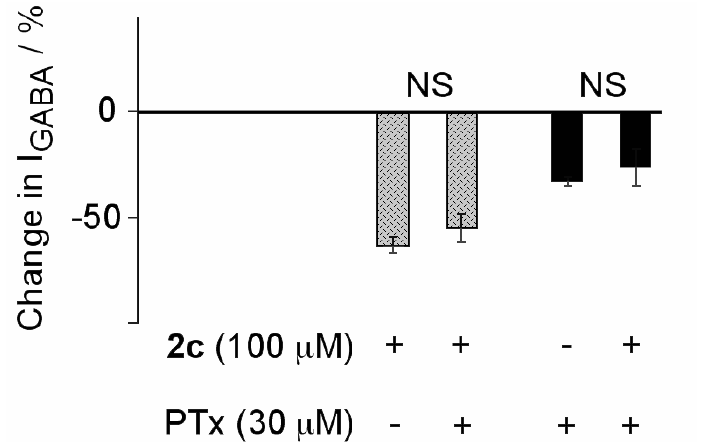
channels was unaffected by picrotoxin (PTx). Figure 9. 2c -induced inhibition of GABA A Bars and lines on their top, are means and SEM (n = 4). Statistical comparison of each pair of bars was done using the paired Student’s t -test. P values and non significant (NS) differences are